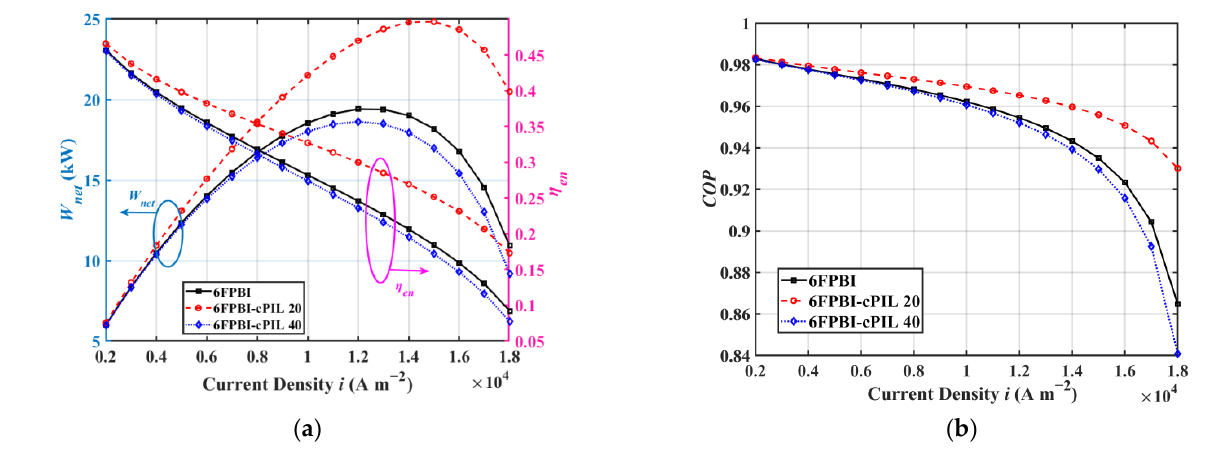
Figure 3. Variation of HT-PEMFC system performance with current density: ( a ) output power 𝑊 𝑛𝑒𝑡 and energy efficiency 𝜂 𝑒𝑛 ; ( b ) the coefficient of performance 𝐶𝑂𝑃 .